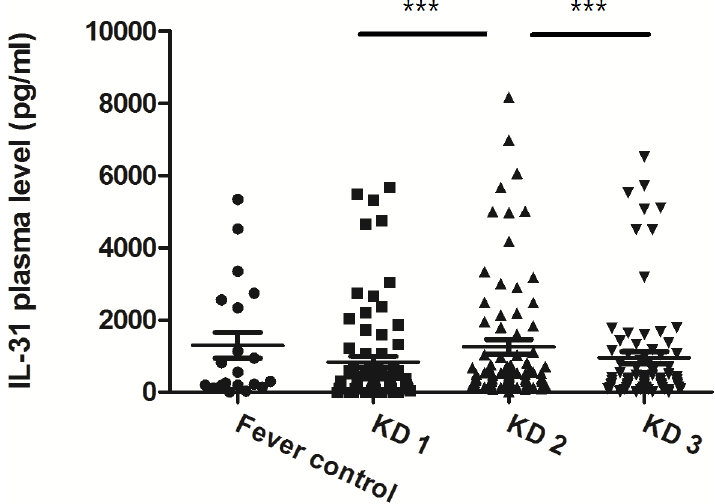
Figure 1. IL-31 was significantly higher in KD2 (within 3 days after IVIG treatment) when compared with KD1 (before IVIG treatment) and KD3 (at least 3 weeks after IVIG treatment). ***P , 0.0005. P values were tested by Paired sample t-test.